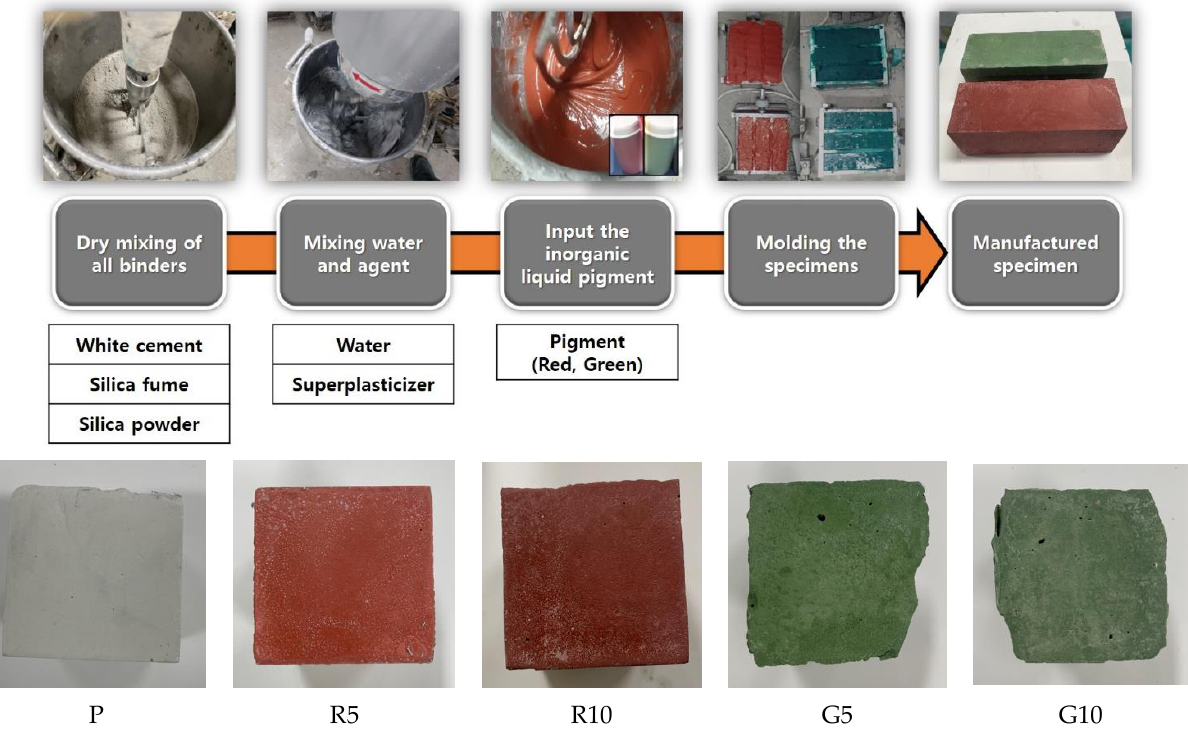
Figure 1. Photographs of HSCCs. Top row: manufacturing process; bottom row: manufactured specimens with different pigment types.